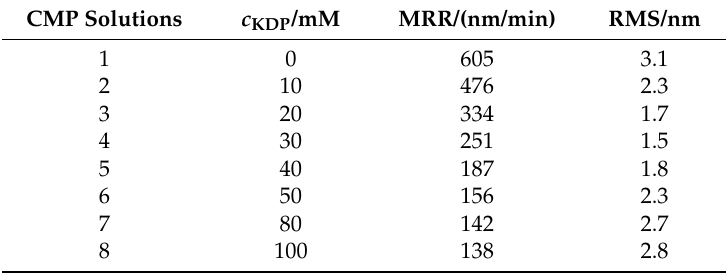
Figure 6. Material removal rate and roughness comparison with different c KDP (from 0 mM to 100 mM). Table 2. Parameters for different microemulsions and their corresponding MRRs for the KDP crystal (polishing condition: temperature 20 C, humidity 40% RH, pressure 5 kPa).